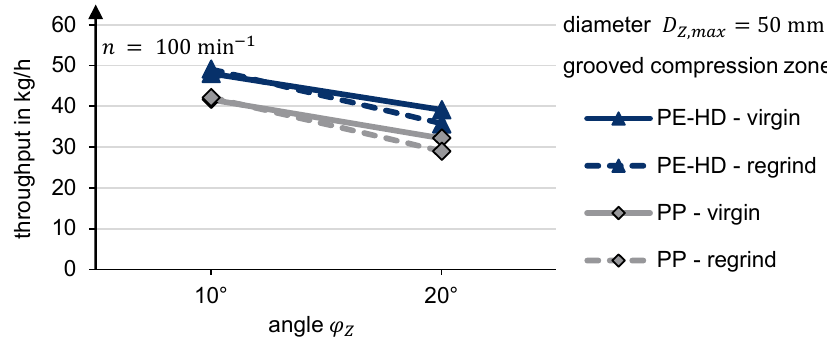
Figure 17. Experimental throughput depending on the angle of the compression zone. Further comparisons of the filling diameter indicate that a compression zone can in- fluence the difference in throughput between regrind and virgin material. D Z,max = 38 mm represents a standard feed zone with a difference of 37% (Figure 18). A larger filling di- ameter reduces the throughput difference. At D Z,max = 50 mm, the throughputs are almost equal. In contrast to virgin material (D Z,max = 65 mm), a larger diameter leads to an even higher throughput of regrind.